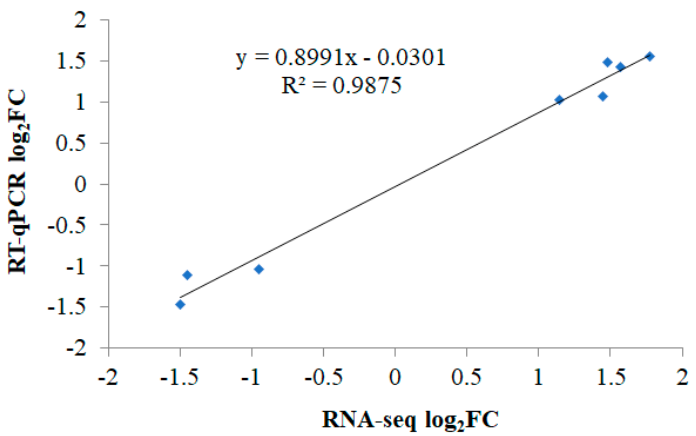
Figure 6. Regression analysis illustrating the correlations between the RNA-seq and RT-qPCR log 2 FC scores for selected DEGs.